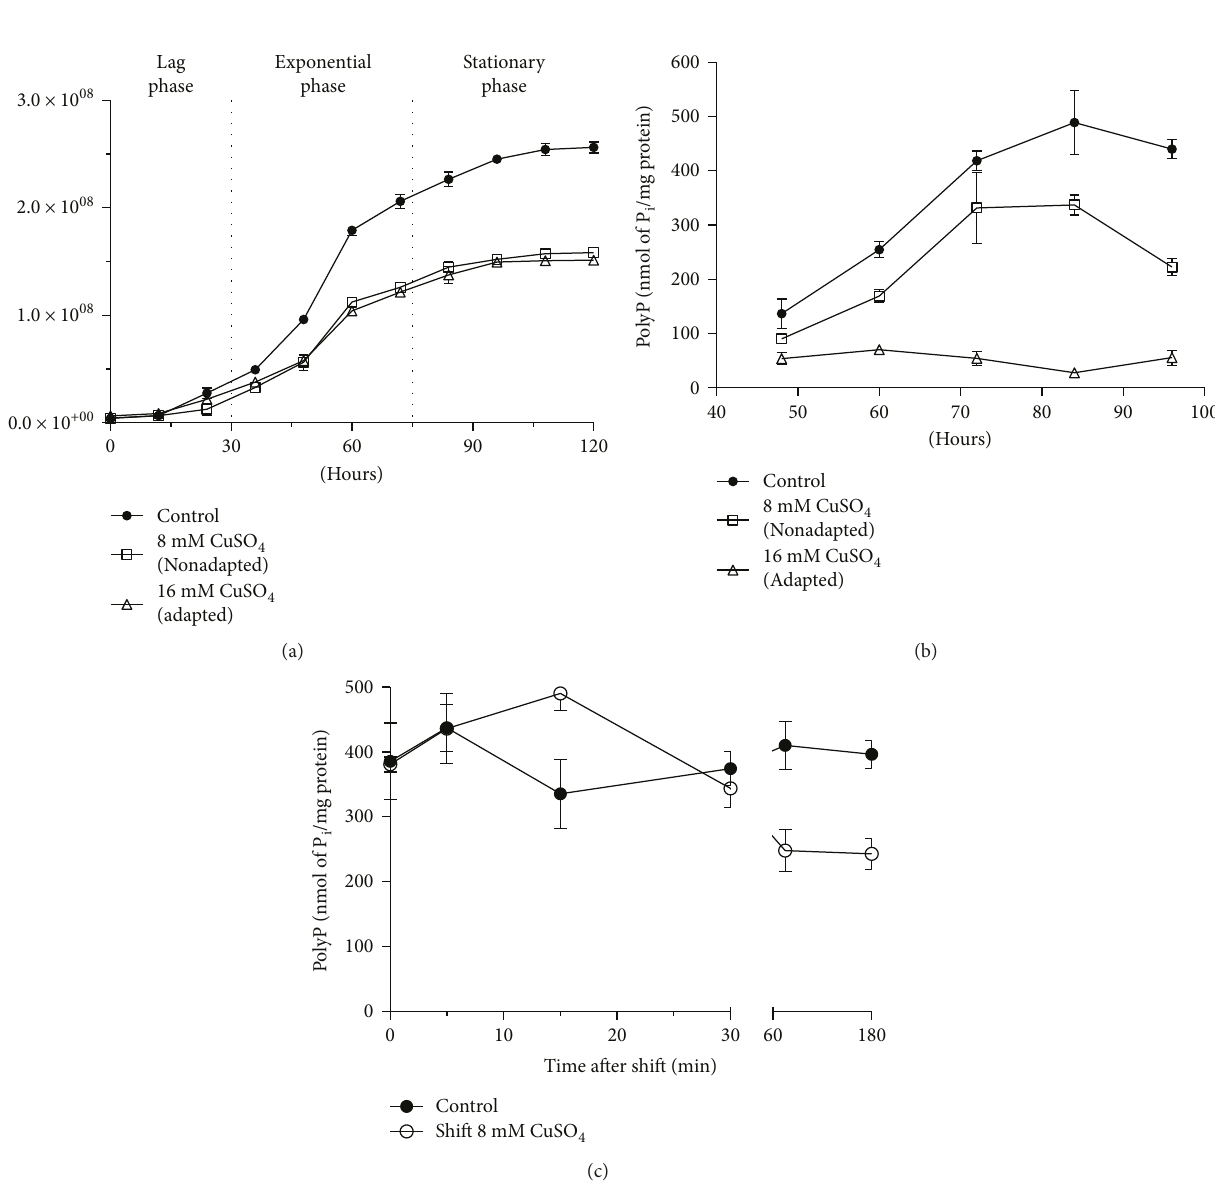
Figure 1: E ff ect of copper ions in the growth and PolyP levels of M. sedula DSM 5348 T . Growth curves (a) and polyP levels (b) were determined at the indicated copper concentrations added upon inoculation. Cells previously grown up to the late exponential phase were shifted to grow at 8mM CuSO at time 0, and polyP levels were immediately determined thereafter at the indicated times after the shift 4